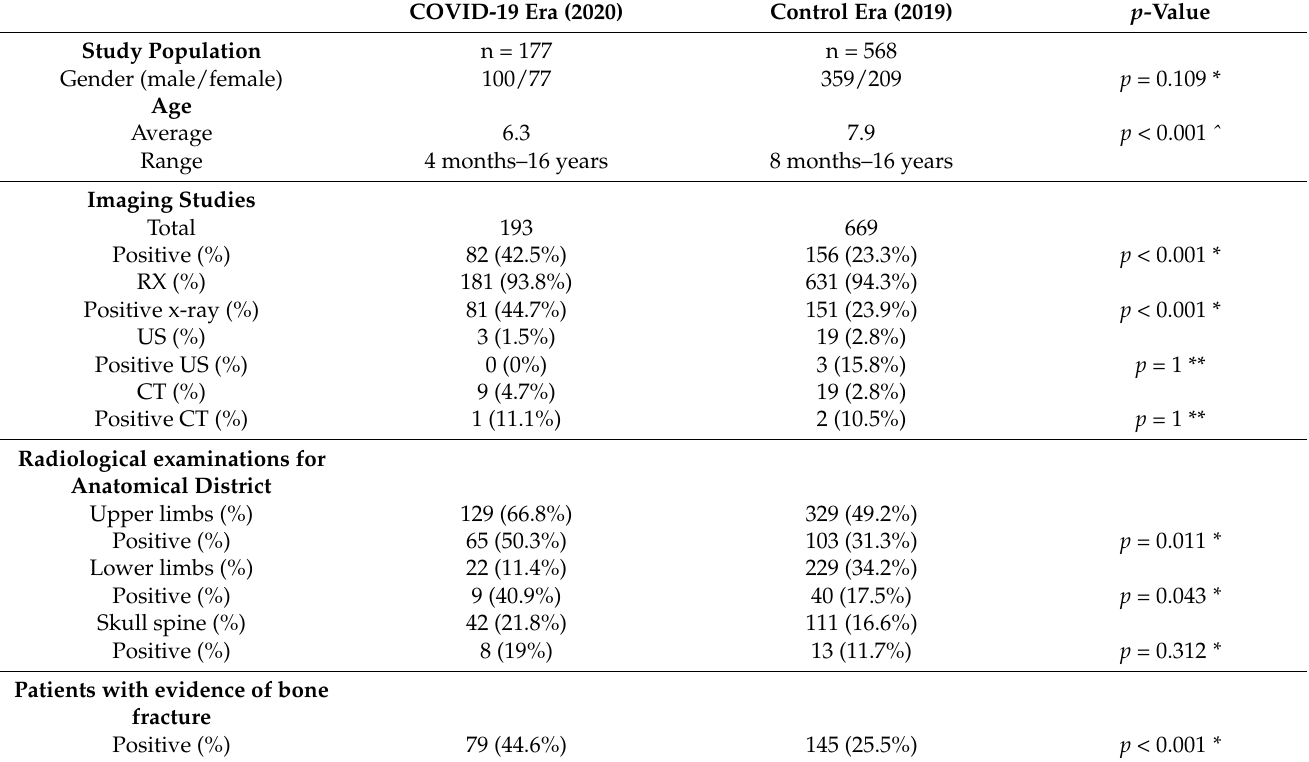
Table 1. Descriptive results of the study population, during the COVID-19 era or during the pre-COVID control